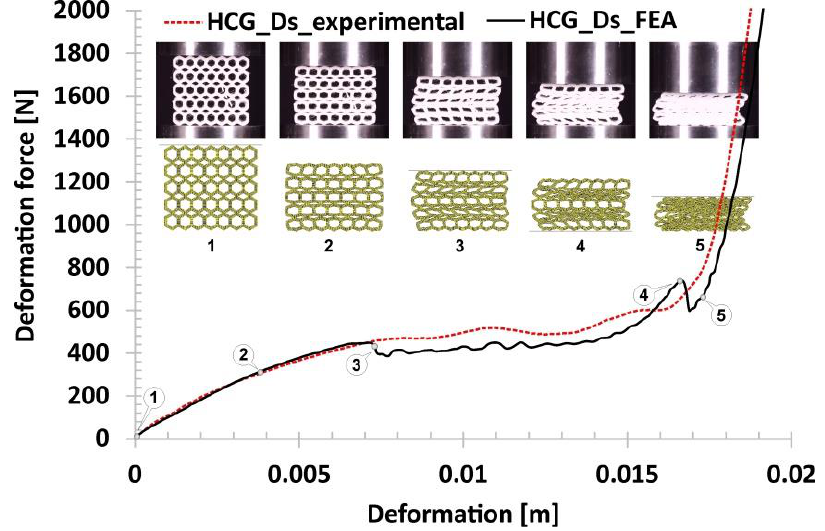
Figure 25. The results of discrete gradient honeycomb compression tests obtained based on the FE analysis.